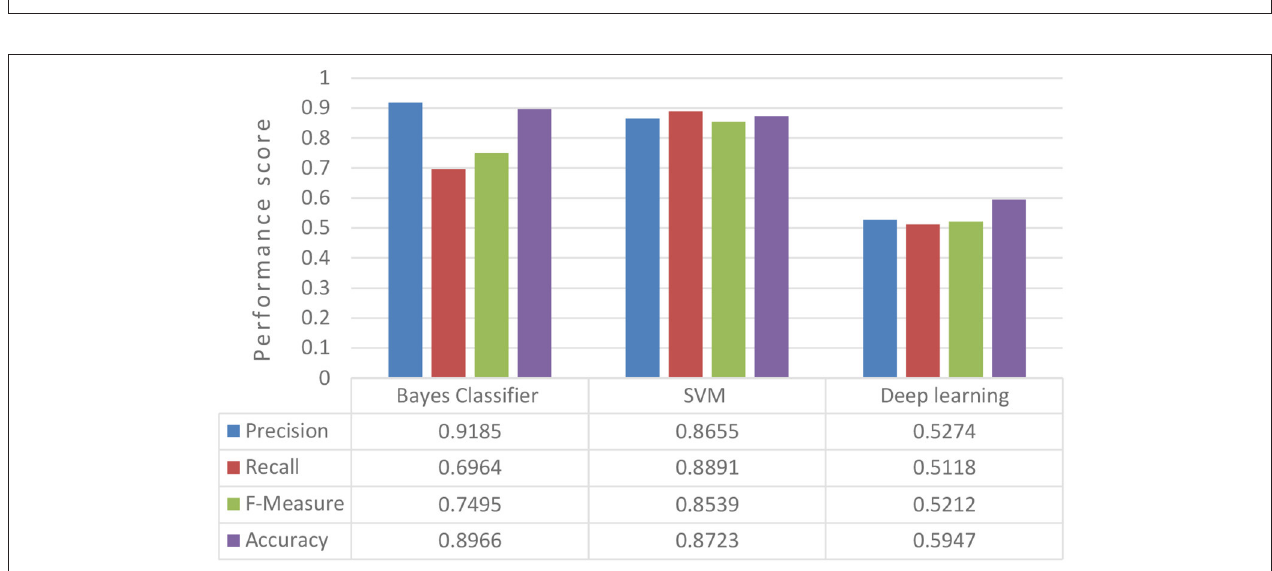
FIGURE 11 | Evaluating classifiers performance with